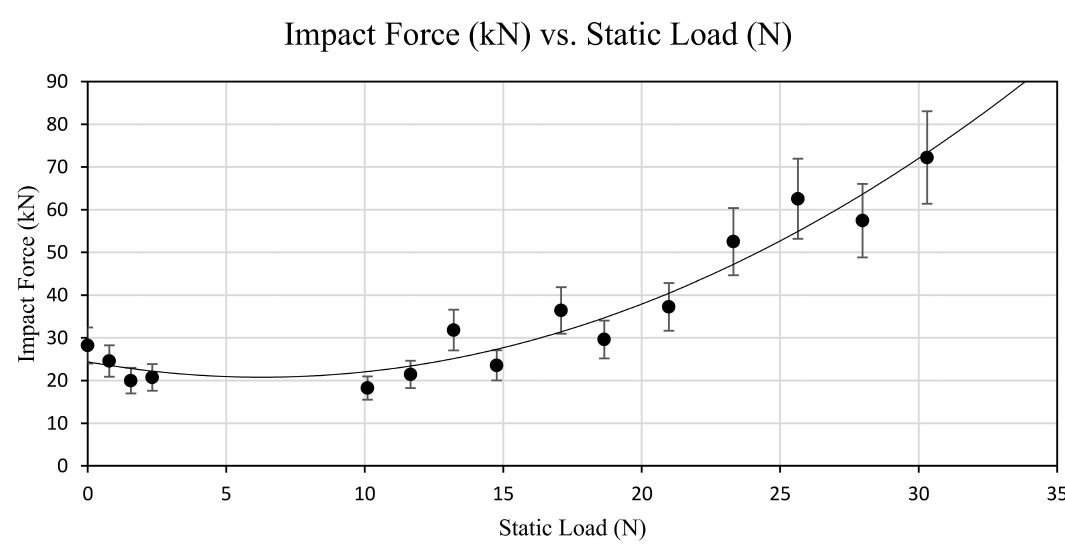
Figure 14. Impact force (kN) vs. static load